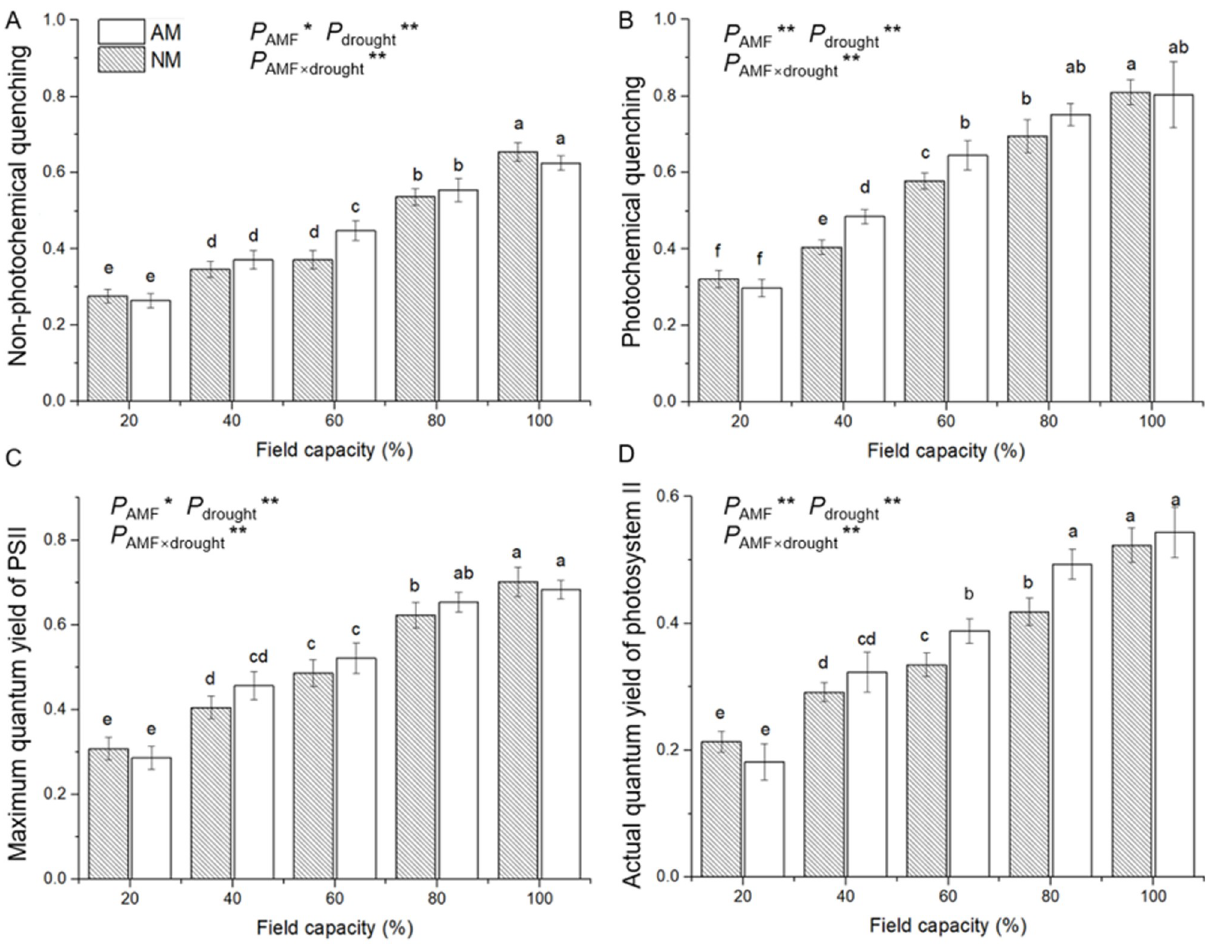
Fig 6. Effect of AM inoculation on chlorophyll fluorescence indexes, qN (A), qP (B), Fv/Fm (C) and F PSII (D) of E . maackii under water deficit. AM inoculated treatment; NM: uninoculated treatment; AMF: effect of AM inoculation; drought: effect of water deficit; AMF × drought: effect of interaction of AM inoculation and water deficit treatment; � : P � 0.05; �� : P � 0.01. Means with a letter in common within each variable can’t be considered different at P � 0.05.